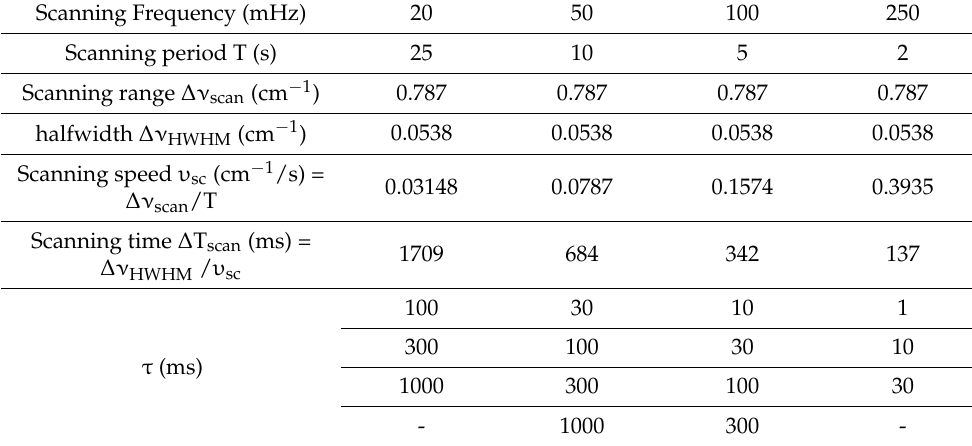
Table 2. Used time constants at a given scanning speed of the LO frequency υ sc . (Note: the spectral half width ∆ ν HWHM of the used CH 4 line around 1233.46 cm − 1 is 0.0538 cm − 1 [20] at ambient